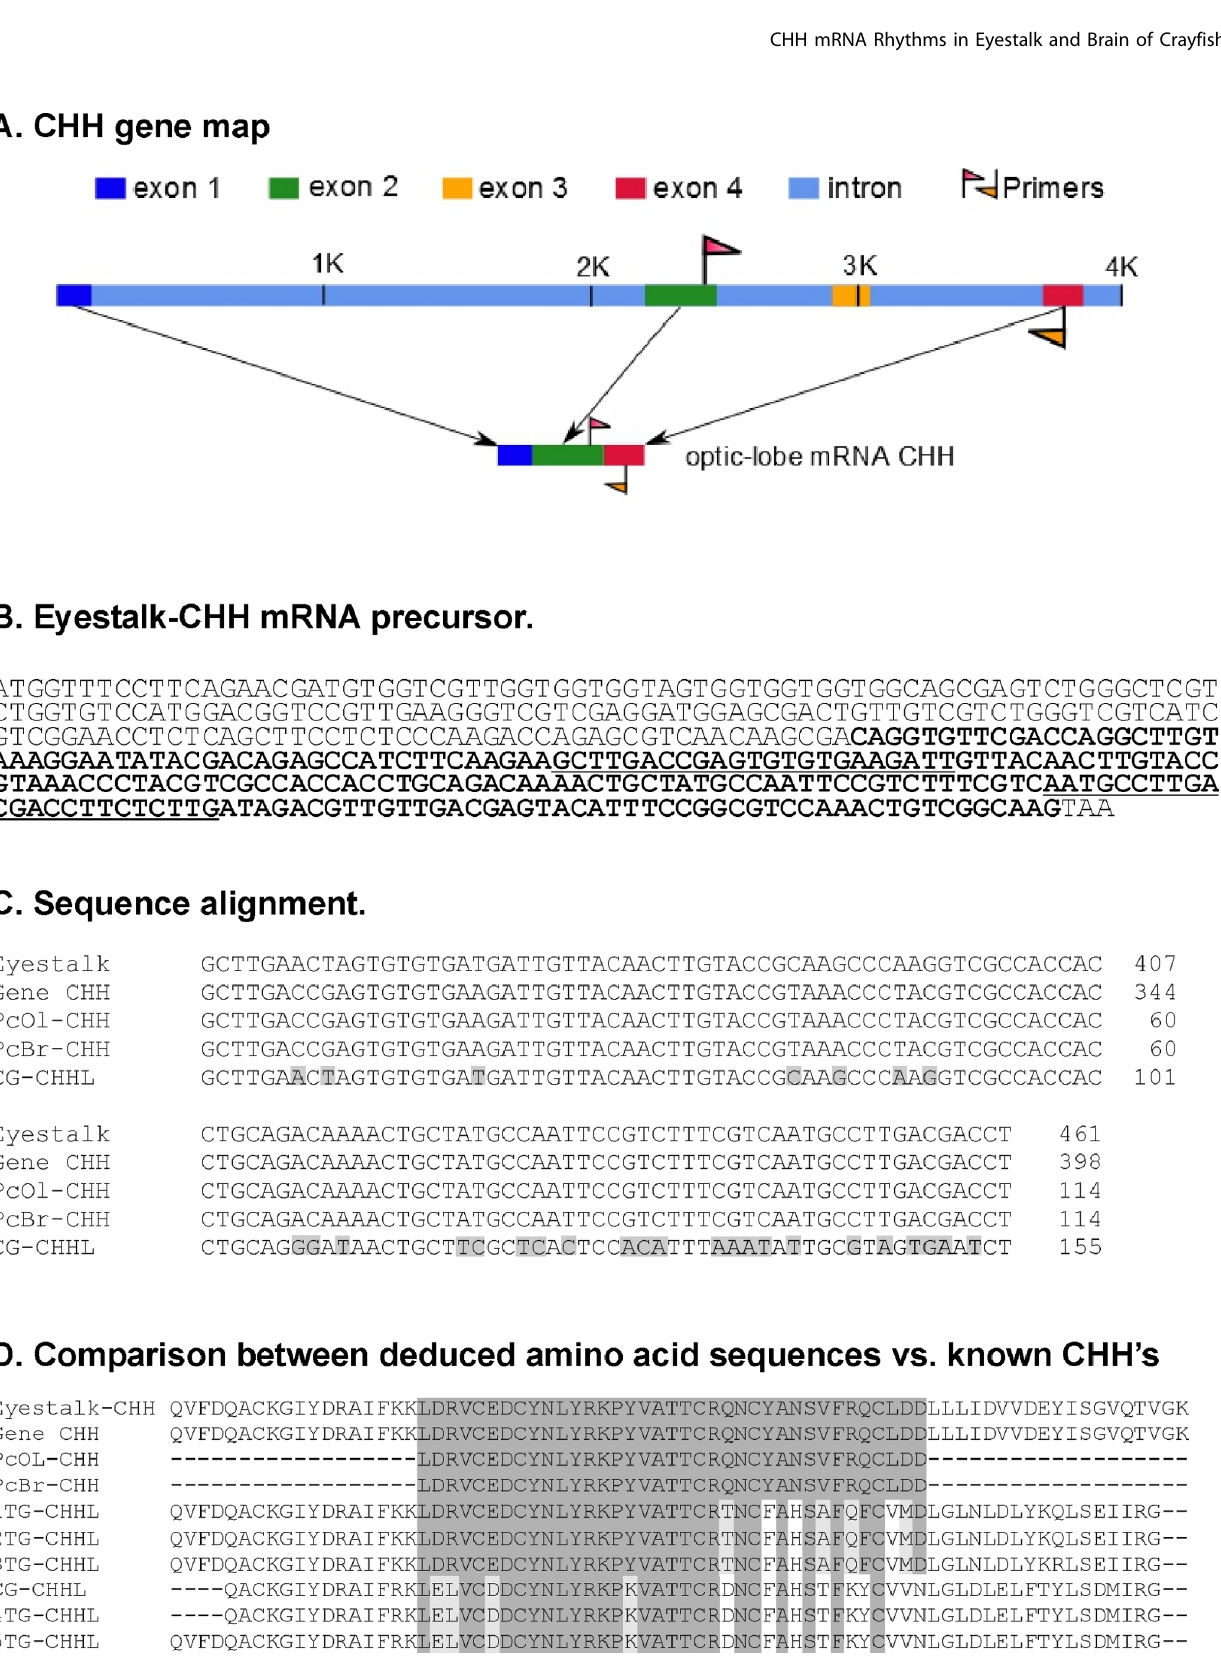
Figure 1. CHH gene map based on GenBank sequence AF474409.1. The position of the exons, introns and the PCR primers within the sequence are marked. The expected amplicon expands between exon 2 and 4. B. The primer position is shown (underlined base pairs) over the eyestalk CHH mRNA precursor sequence (Gene Bank acc. no. AB027291.1). Bold letters represent the coding region of the CHH protein. C. Base pair sequence alignment between the eyestalk CHH mRNA precursor (Eyestalk-CHH) and the amplicon sequences obtained in this work: the optic lobe